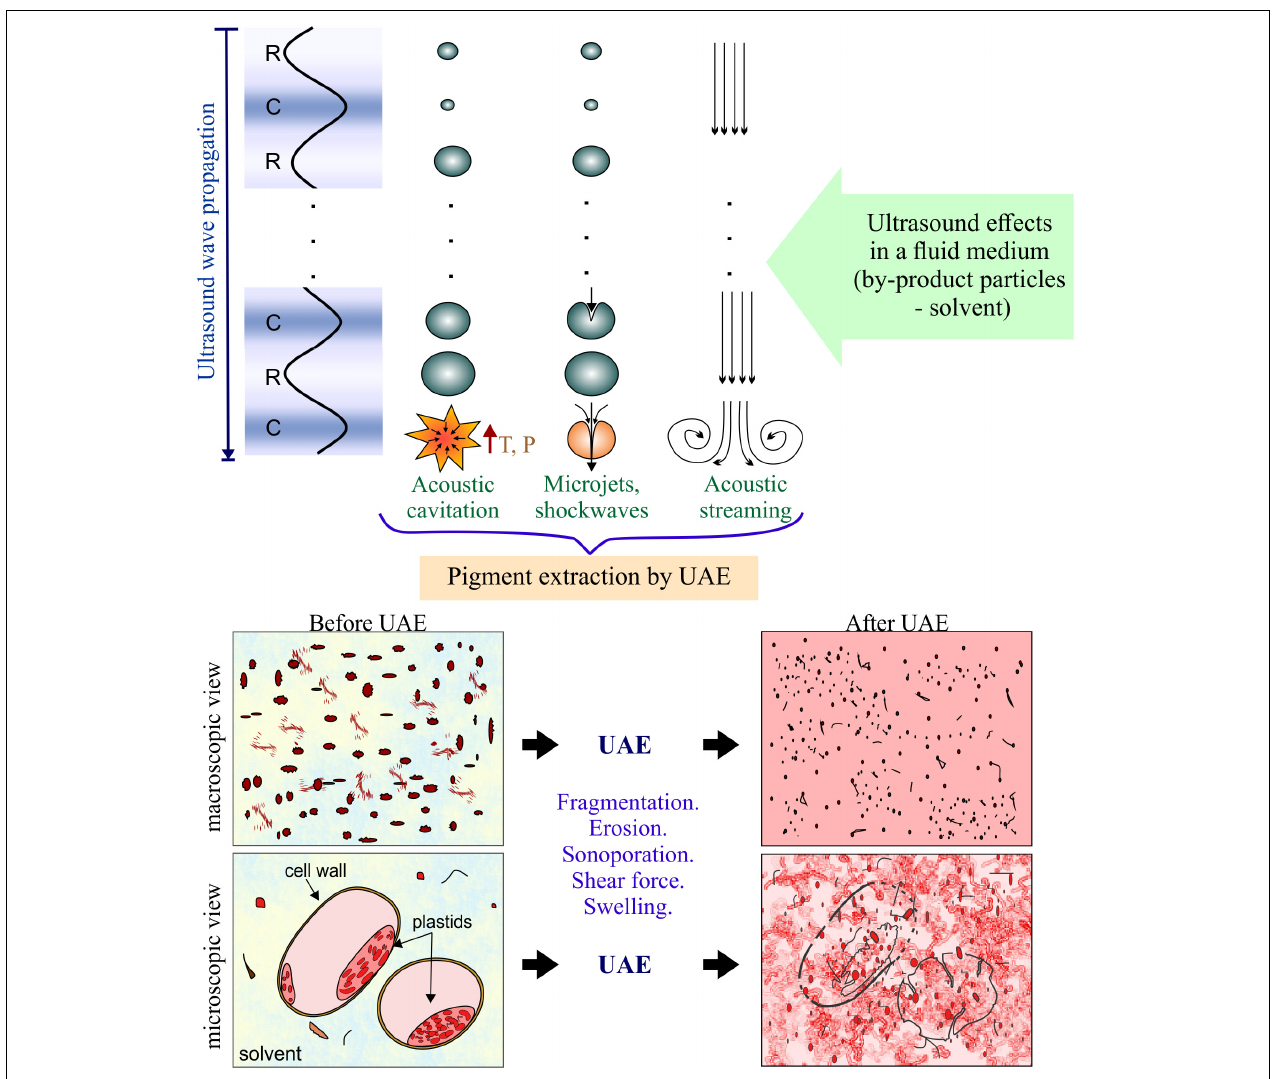
FIGURE 2 | Ultrasound effects that promote mechanisms of pigment extraction through UAE processing.